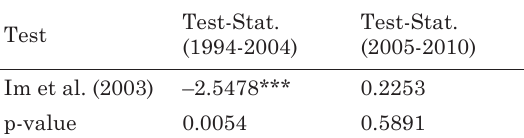
table 3. IPs panel unit root